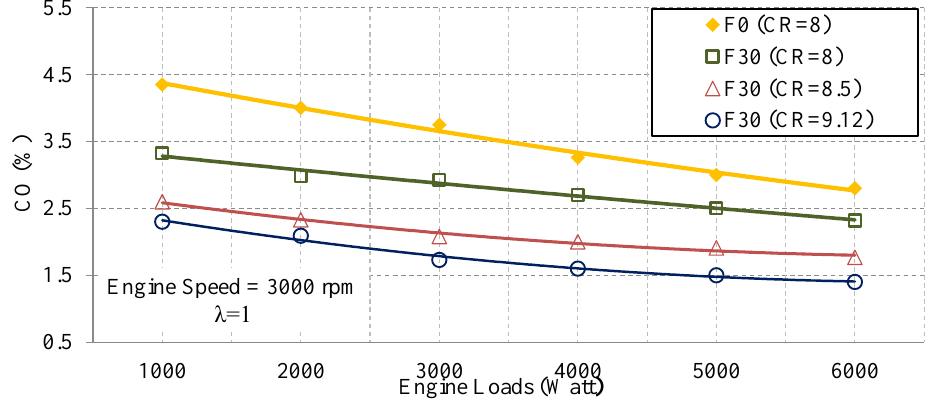
Figure 10. CO graph for F0 and F30 at different compression ratios.